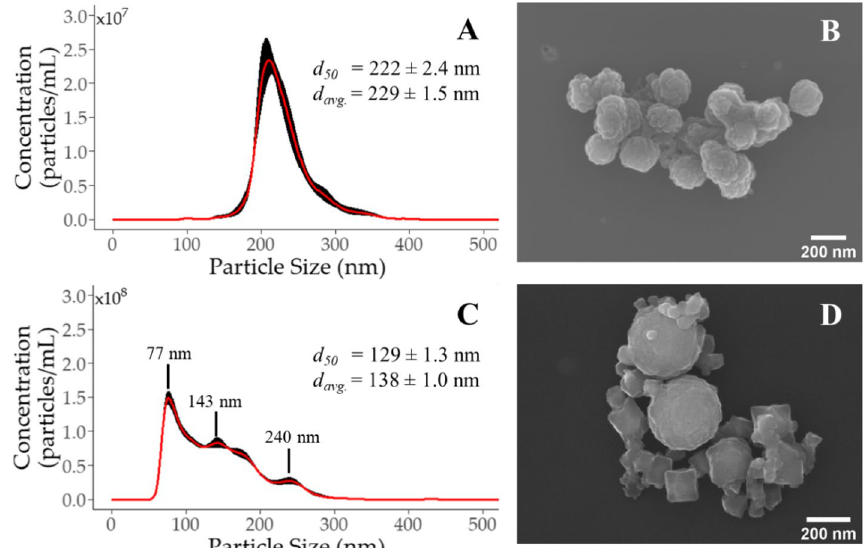
Fig. 2 Particle size distribution (PSD) and SEM micrograph of ( a , b ) PAN-Pd@PS NPs and ( c , d ) HDTMS-FeNPs, respectively. Error bars (black) indicate 1σ ( n 5) ± =